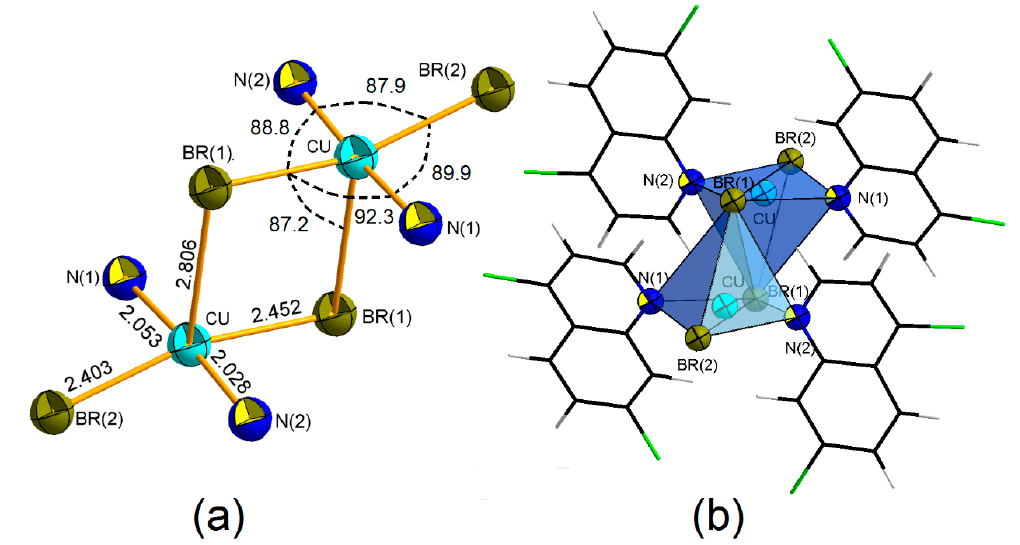
Figure 3. Structure of the binuclear coordination complex CDCQB, as determined by single-crystal X-ray di ff raction at T = 100 K. Color code is as in Figure 1. Thermal ellipsoids are drawn at the 99% probability level. ( a ) Geometry of the two inversion-related metal centers. Distances are in Å and angles in degrees. ( b ) Coordination polyhedra, highlighting the distorted square pyramidal geometry, with respect to the relative orientation of organic ligands. Black lines serve only as guides for the eye.